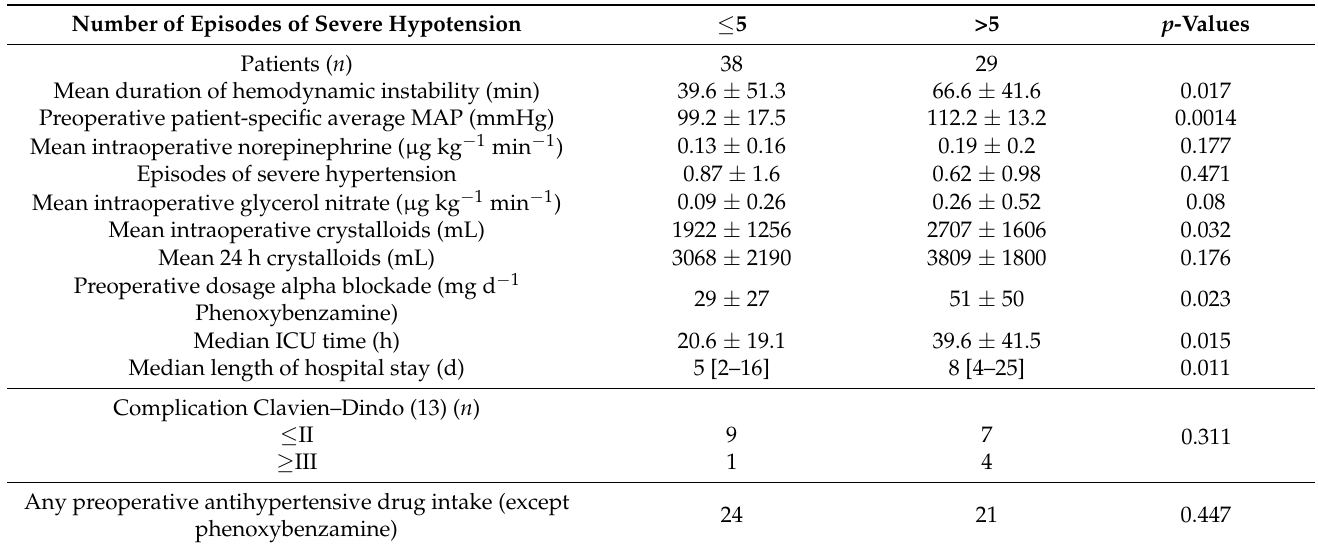
Table 2. Details of preoperative average MAP, along with episodes and duration of hemodynamic